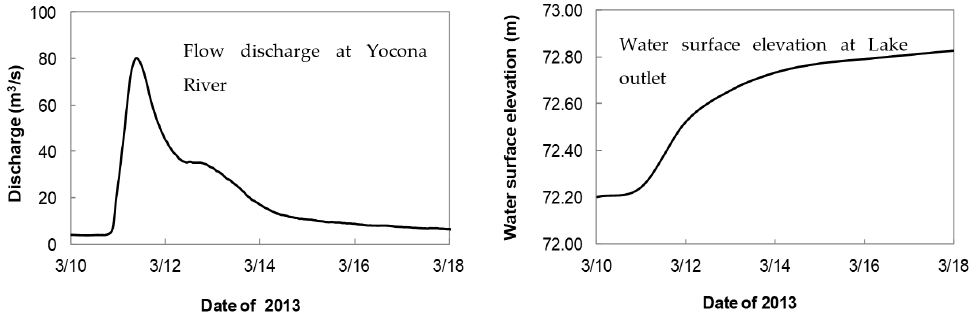
Figure 2. Flow conditions at the boundary (10 March 2013–18 March 2013).